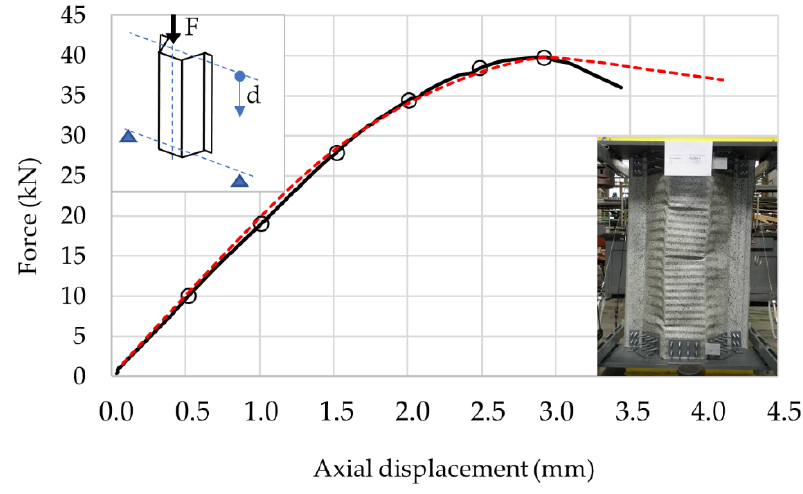
Figure 6. Model 0. An equilibrium force–displacement path at an eccentric compression. The numerical values of the equilibrium path checkpoints are presented in Table 2. The last reference point represents the maximum force and the corresponding displacement. Table 2. Model 0 sample: the equilibrium path’s control points.